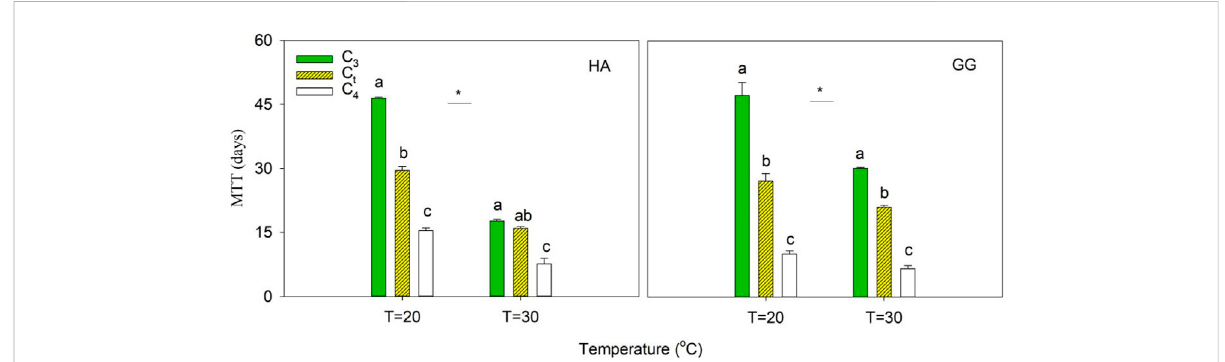
FIGURE 4 The microbial turnover time (MTT) of C 3 -derived, C 4 -derived, and total C (C t ). Error bars show ±SE ( n = 3). Different lowercase letters denote signi fi cantdifferencesat p < 0.05levelamongtheMTTofC 3 ,C 4 ,andC t .Asteriskindicatesasigni fi cantdifferenceofC 3 ,C 4 ,andC t at p < 0.05between T = 20 C and T = 30 ° C,